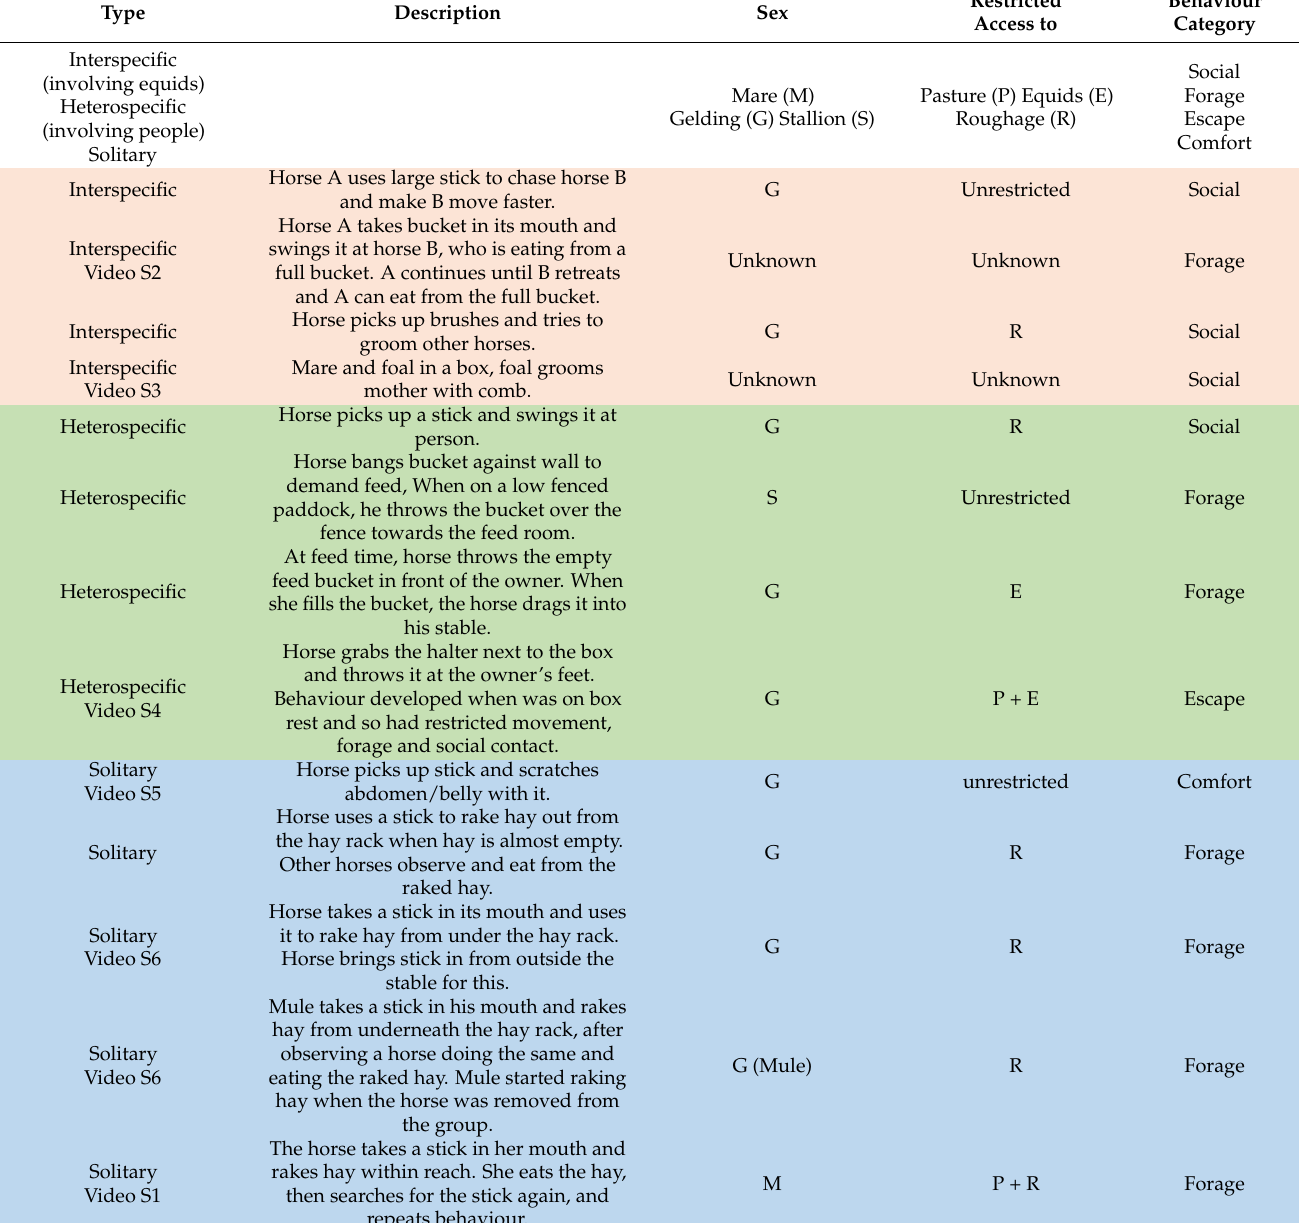
Table 1. Tool use in equids categorized according to its direction: interspecific = directed towards other equids (brown), heterospecific = directed towards humans (green), solitary = for the tool using animal itself